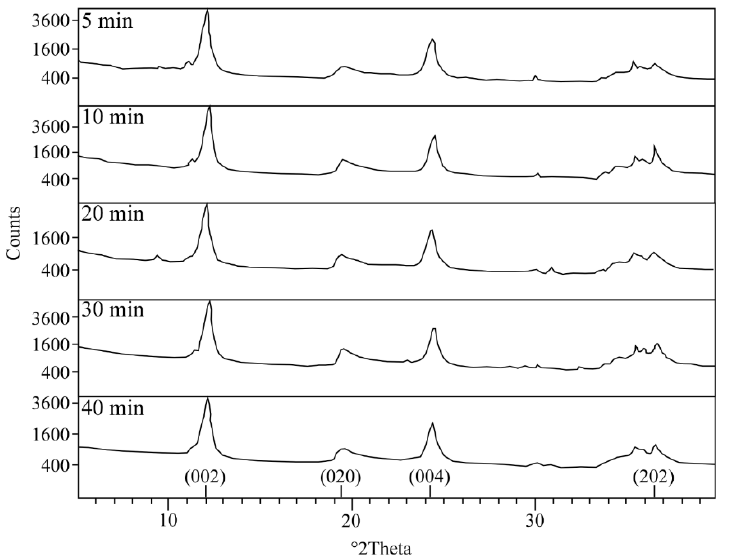
Figure 3. X-ray diffraction pattern of cryo-milled chrysotile with different time of milling. The main diagnostic peaks for chrysotile with their Miller indices are shown.